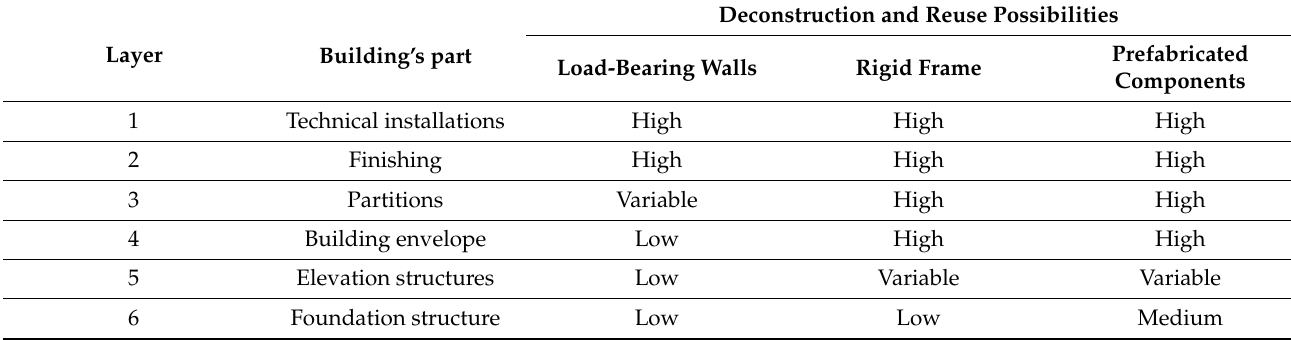
Table 5. Deconstruction and reuse potential for the constructive